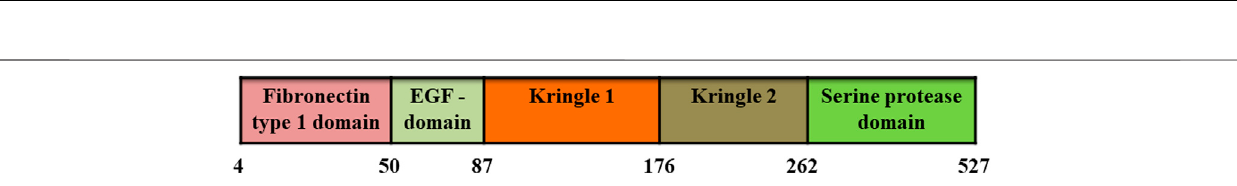
Frontiers in Molecular Biosciences |